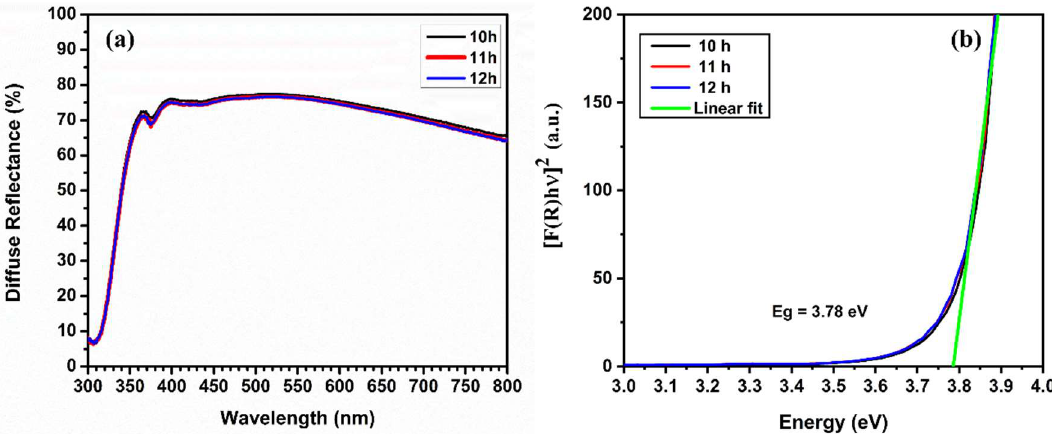
Figure 7. ( a ) Diffuse reflectance spectra and ( b ) direct bandgap of the CdCO 3 films deposited at 10, 11, and 12 h.